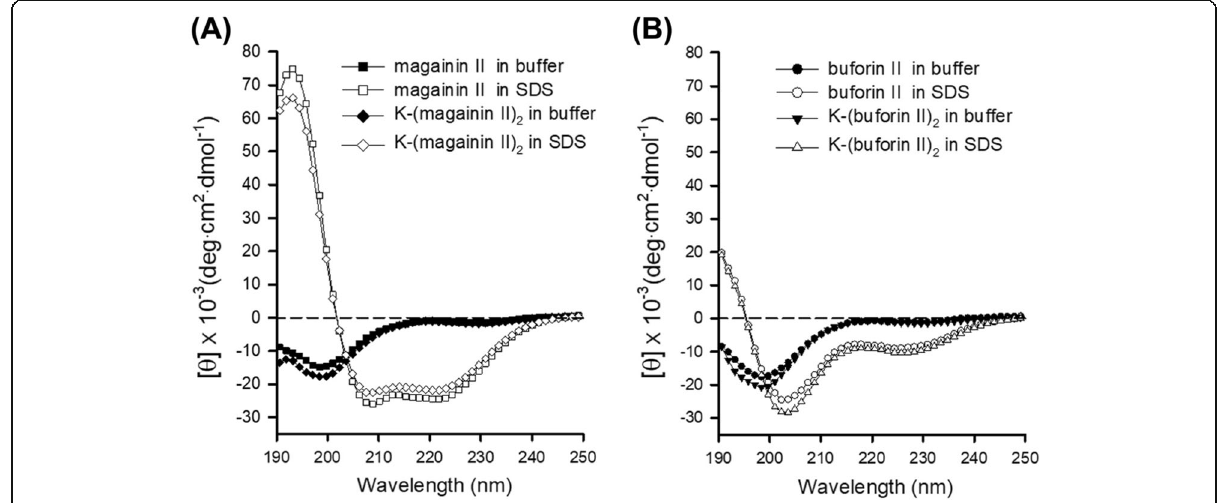
Fig. 1 CD spectra of the peptides. The CD spectra of magainin II and K-(magainin II) 2 ( a ) and buforin II and K-(buforin II) 2 ( b ) were obtained at 25 °C in 10-mM sodium phosphate buffer (open symbols) or 30 mM SDS micelles (closed symbols). Spectra were taken at peptide concentrations of 20 μ